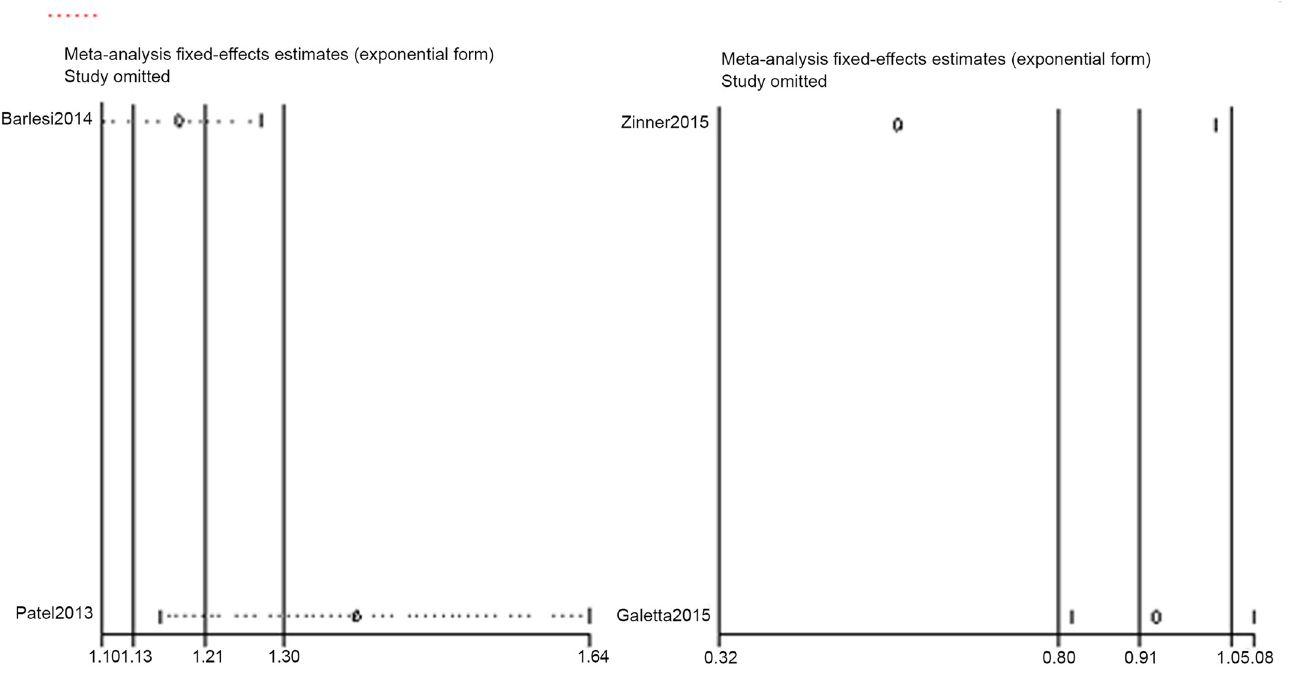
Fig 7. Sensitivity analysis result of grade 3 – 4